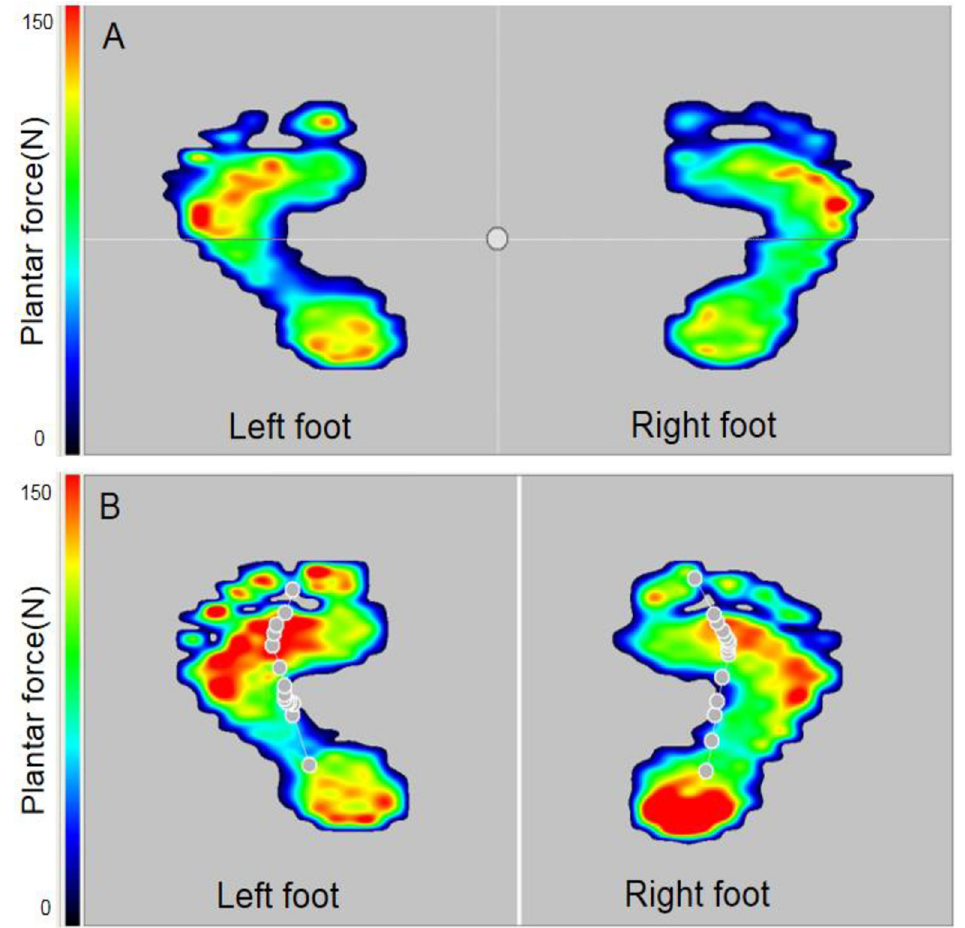
Fig 1. Diagrams of (A) static and (B) dynamic pressures of the barefoot tested using Gaitview system.